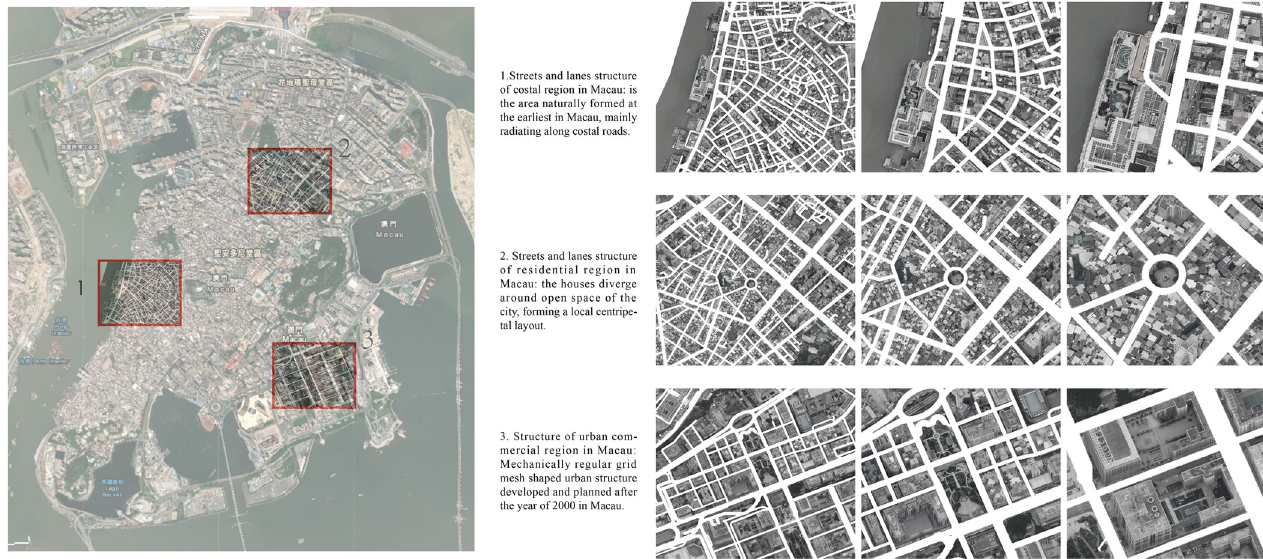
Fig 7. Structural features of the streetscape in Macau. Reprinted from [http://earthobservatory.nasa.gov/] under a CC BY license with permission from [NASA Earth Observatory], original copyright [2019].